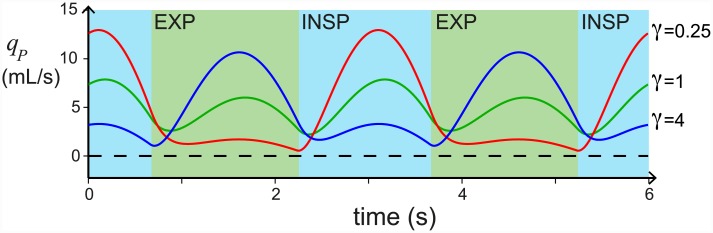
The ratio of compliances γ = C1/C2 changes the shape of the oscillatory flow qP.This figure plots the flow rate qP versus time, for γ = 1/4 (red), γ = 1 (green), and γ = 4 (blue). The inspiratory period (INSP) is shaded blue, and the expiratory period (EXP) is shaded green. All other parameters are as given in Table 1.